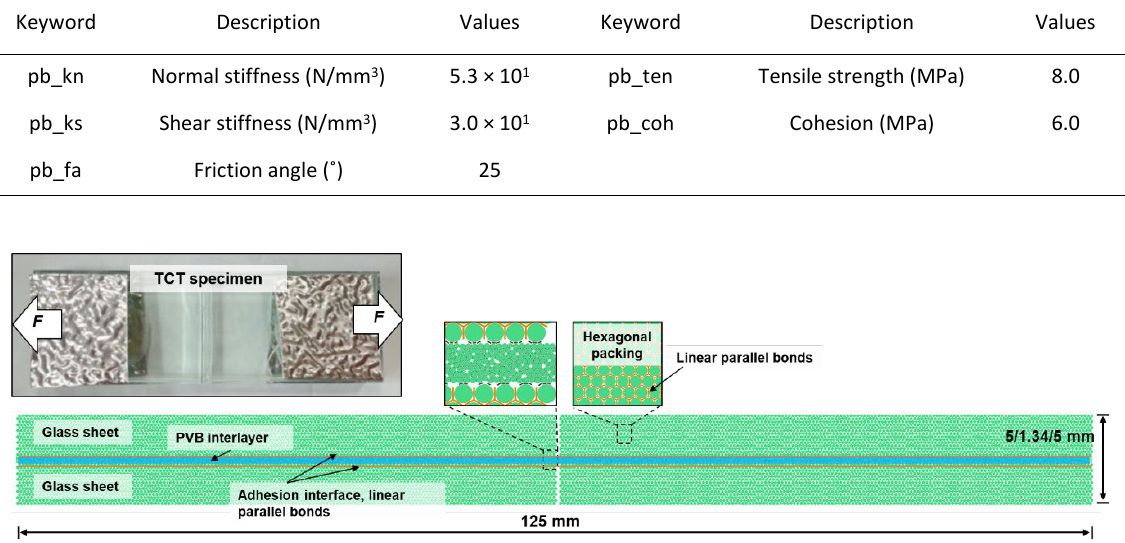
Table 2: Calibrated microscopic bond parameters of glass-PVB adhesion